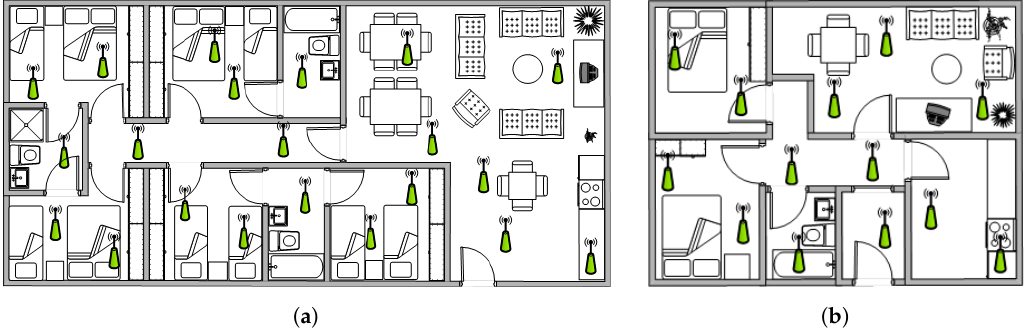
Figure 2. Detail of the alternative implementation of an acoustic alarm service, taking into account the sensing of all the available spaces in each type of living place. ( a ) Residence site, with several buildings/houses with common spaces (dining room, etc.) and with private facilities for elderly or pseudo-dependent; ( b ) Isolated flats where elderly or pseudo-dependent people need basic surveillance